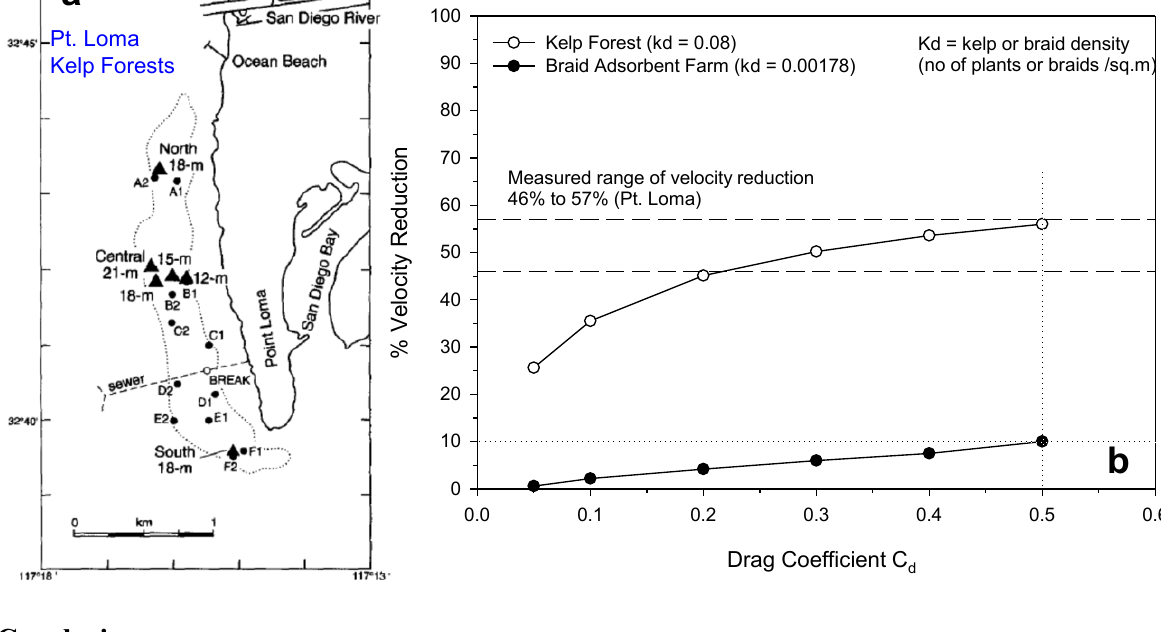
Figure 5. ( a ) Map of the Point Loma kelp forest offshore of the California coast. The dotted line represents a general outline of the kelp canopy (map adapted from Tegner et al. [22] with permission from Elsevier). ( b ) Predicted potential reductions in ambient currents by the kelp forest and braid adsorbent farm with typical canopy/mooring densities. Predicted Velocity Reduction in Kelp Forest